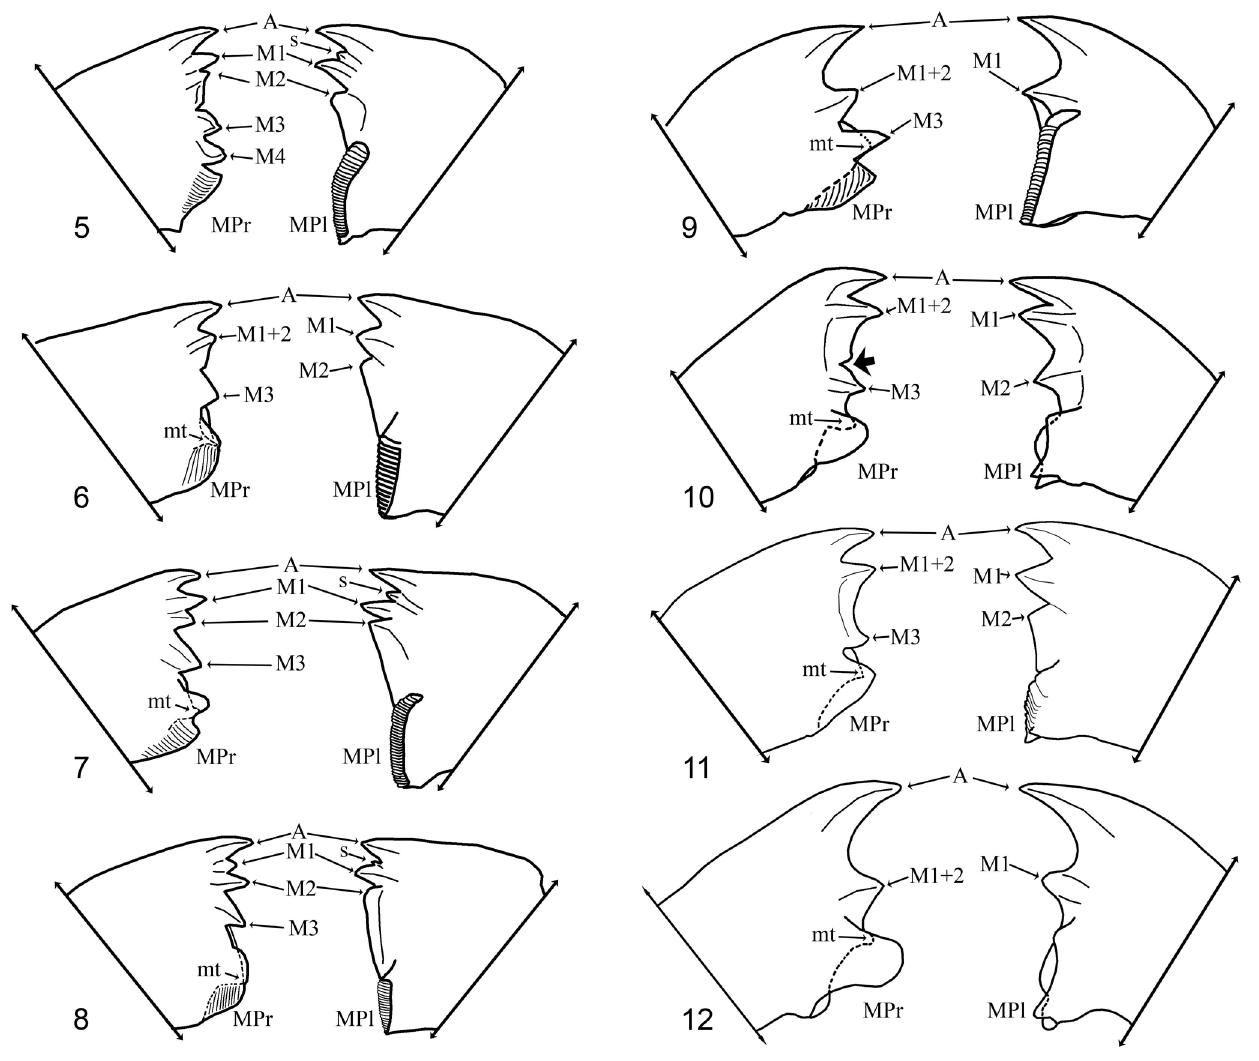
Figs 5–12. Worker mandibles in dorsal view: 5- Porotermes quadricollis ; 6- Rugitermes rugosus ; 7- Rhinotermes marginalis ; 8- Coptotermes gestroi .; 9- Glossotermes oculatus ; 10- Anoplotermes pacificus , 11- Microcerotermes sp., 12- Crepititermes verruculosus , [apical tooth (A), subsidiary tooth (s), marginal tooth 1, 2, 1+2, 3, 4 (respectively M1, M2, M1+2, M3, M4), molar tooth (mt), molar prominence (MPr) and molar plate (MPl)], (figures not to